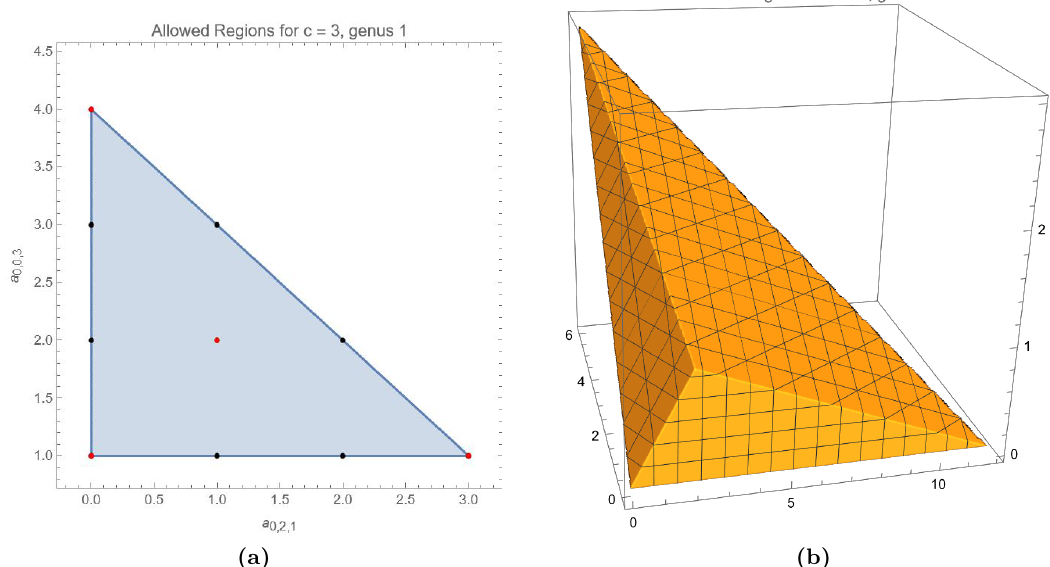
Figure 2. Allowed regions for n = 3 . Plot (a): 2d region for genus 1. Dots represent polynomials with integer coefficients. Red dots, appearing at (0 , 1) , (3 , 1) , (1 , 2) , and (0 , 4) , represent factor- ization limits of genus 2 polynomials, as well as physical code theories. Plot (b): rough 3d plot of genus 2 allowed region. Remarkably, the factorizing, positive integer solutions lie on the vertices of this